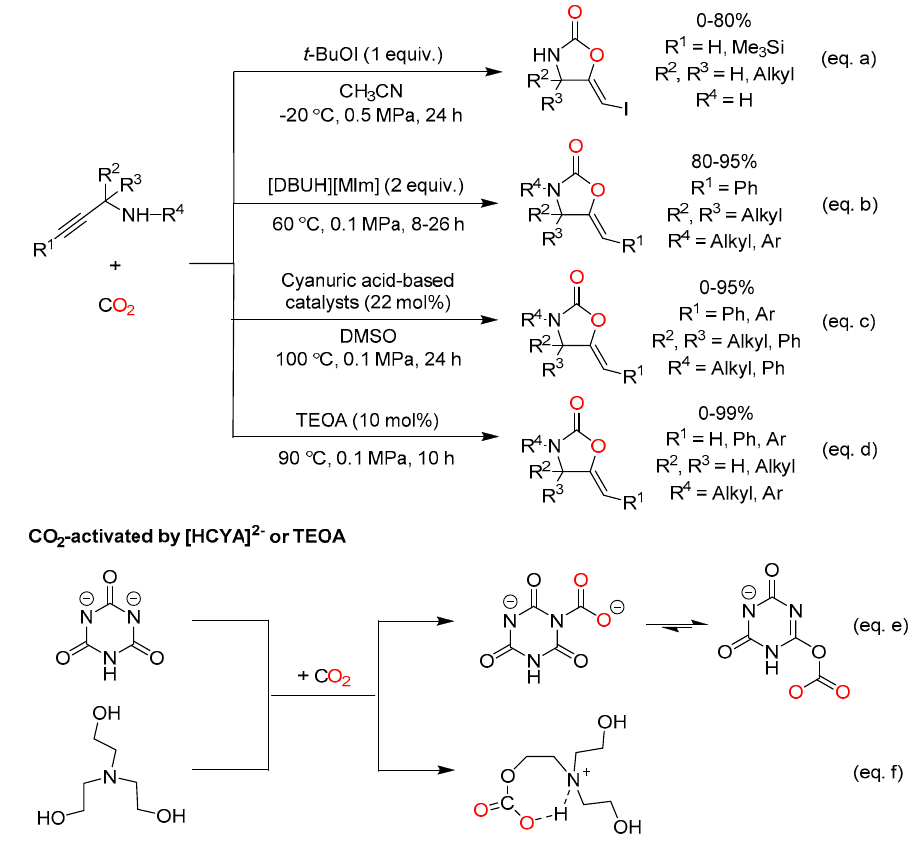
Scheme 8. Synthesis of 2-oxazolidinones by metal-free catalytic